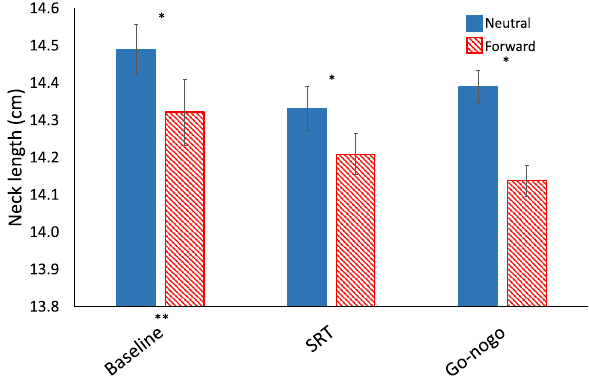
Fig. 5 2 × 3 ANOVA comparing the effects of head position on neck length (cm), with factors for condition (solid blue = neutral; red stripes = forward) and task (baseline, simple reaction time (SRT), and go-nogo). Error bars represent standard error. Asterisks repre- sent significant effects ( p < 0.05). * Main effect of condition showing that participants’ neck length is shorter in the forward condition. ** Main effect of task on neck length showing participants neck length was shorter during SRT and go-nogo than baseline